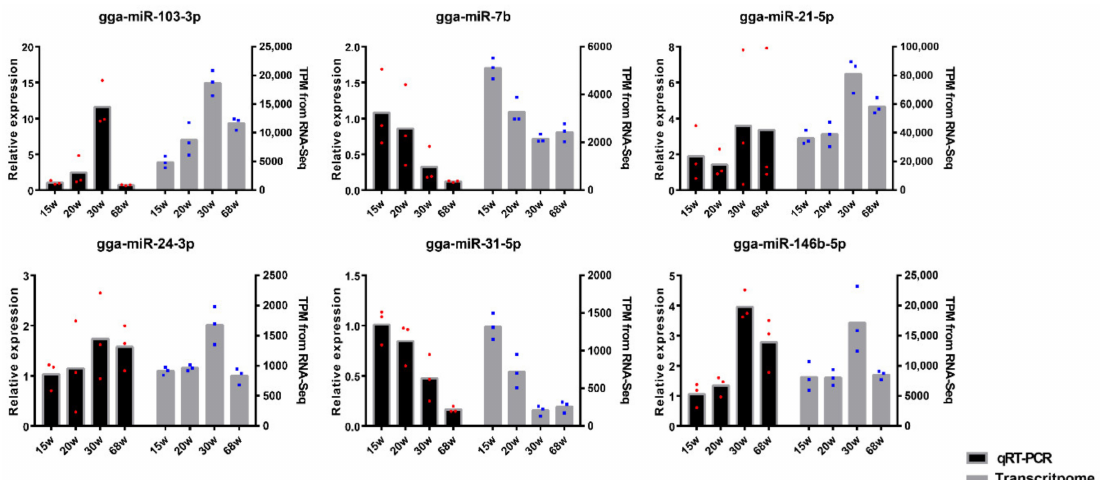
Figure 5. The validation of highly expressed miRNAs between qRT-PCR and the transcriptome. The left y-axis of the above graph shows the value of relative expression and the right y-axis shows the value of transcript per million (TPM). The red and blue dots correspond to the three biological